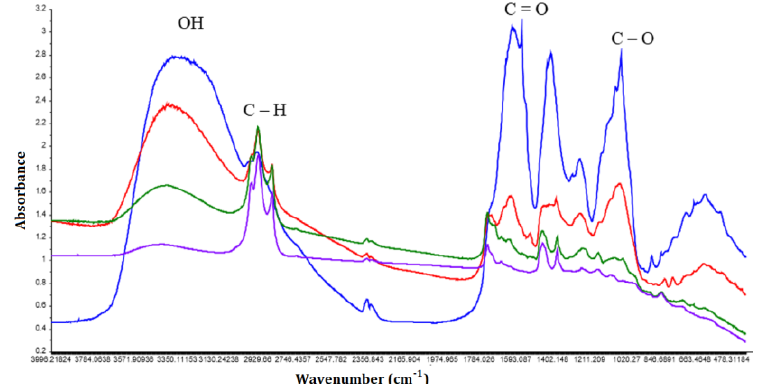
Figure 1. Representative of FTIR spectrum derived from extract of G. ulmifolia leaves (− water, − ethanol, − ethyl acetate, − n -hexane)